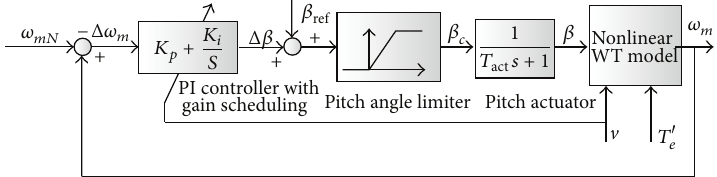
Figure 6: System frame of LCNM based scheme.